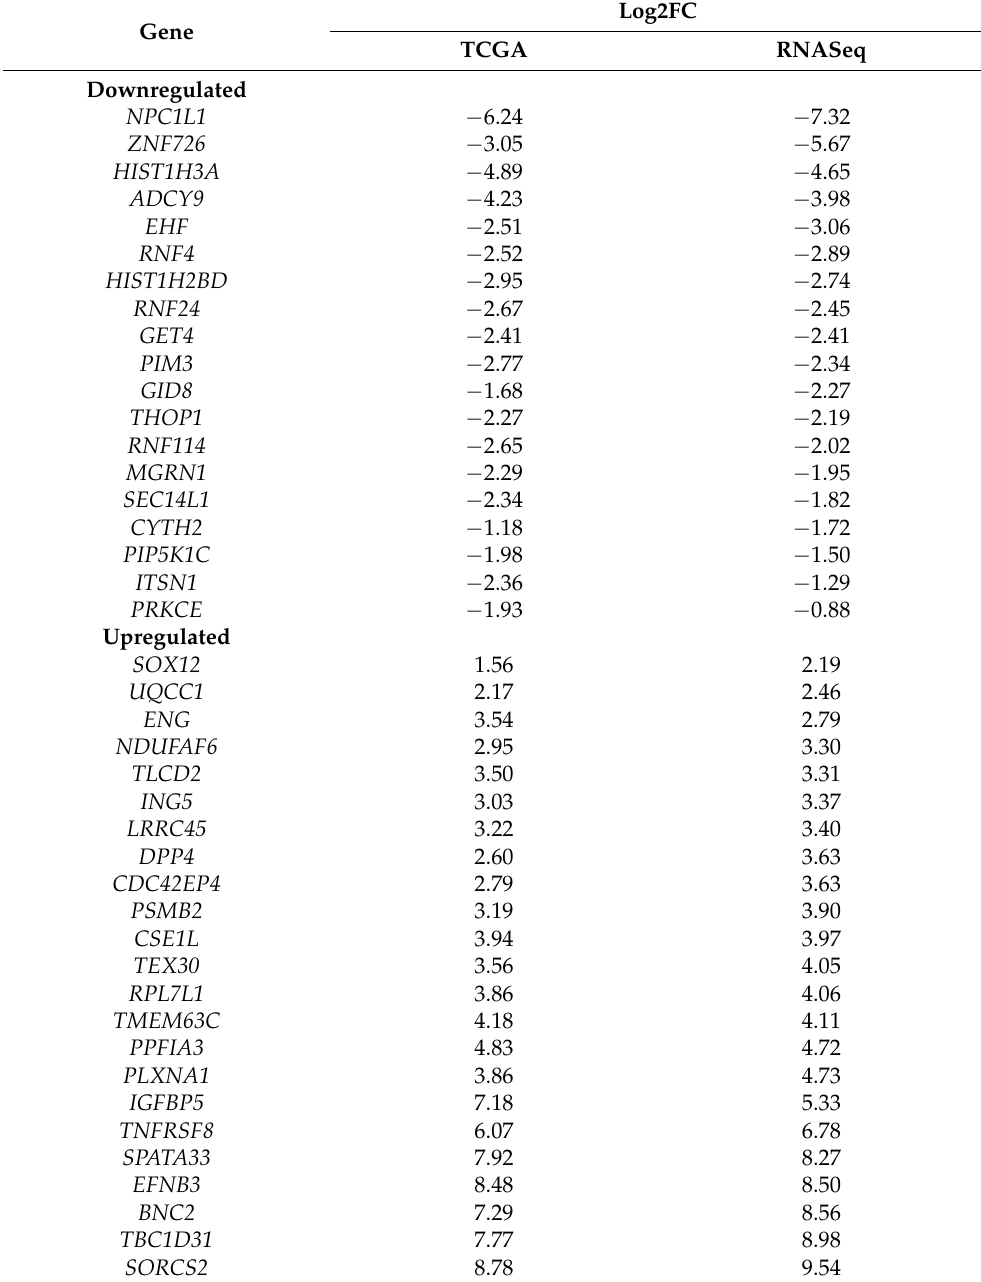
Log2FC TCGA RNASeq